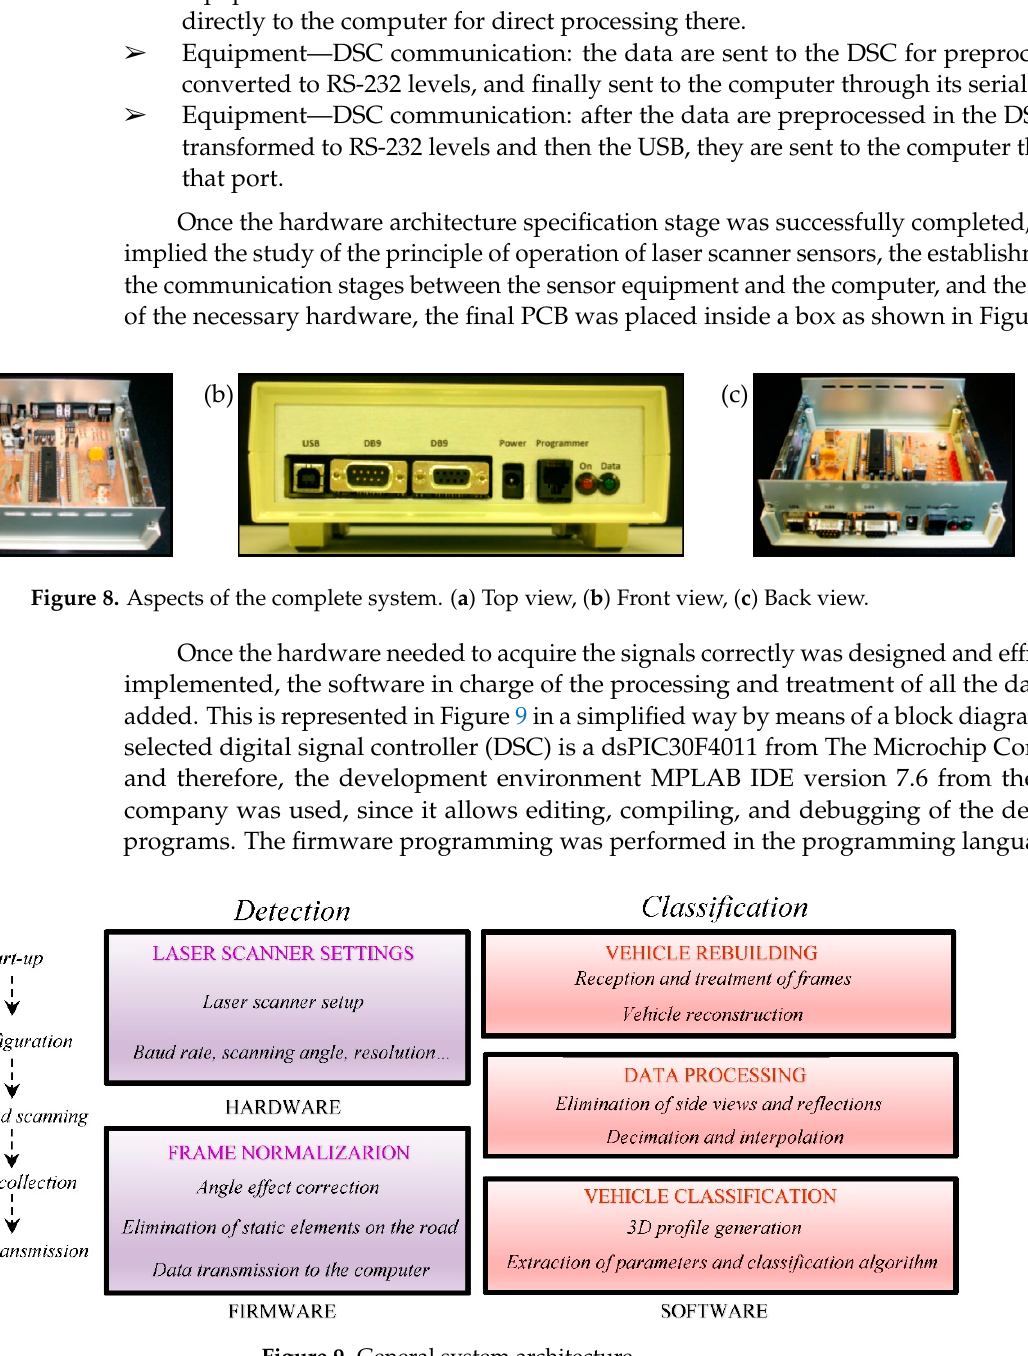
Figure 9. General system architecture.